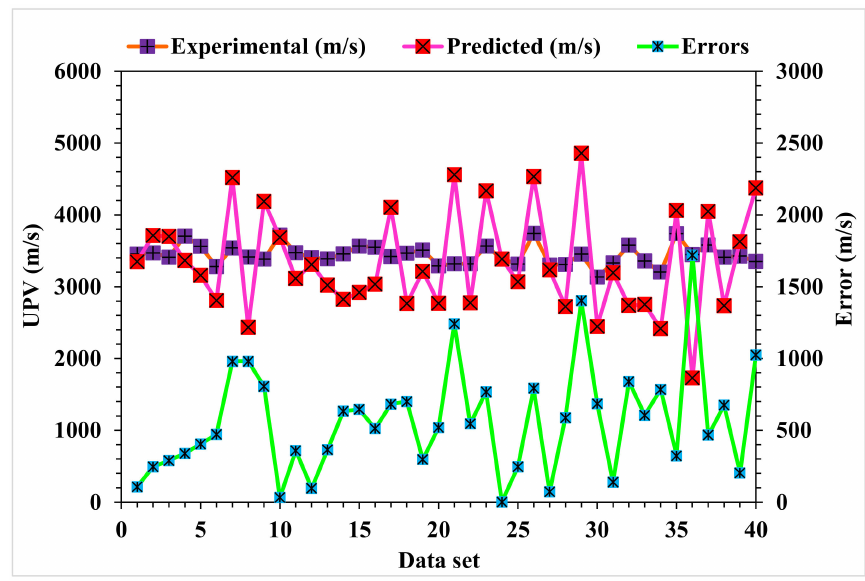
Figure 7. MLPNN model experimental and predicted values with the